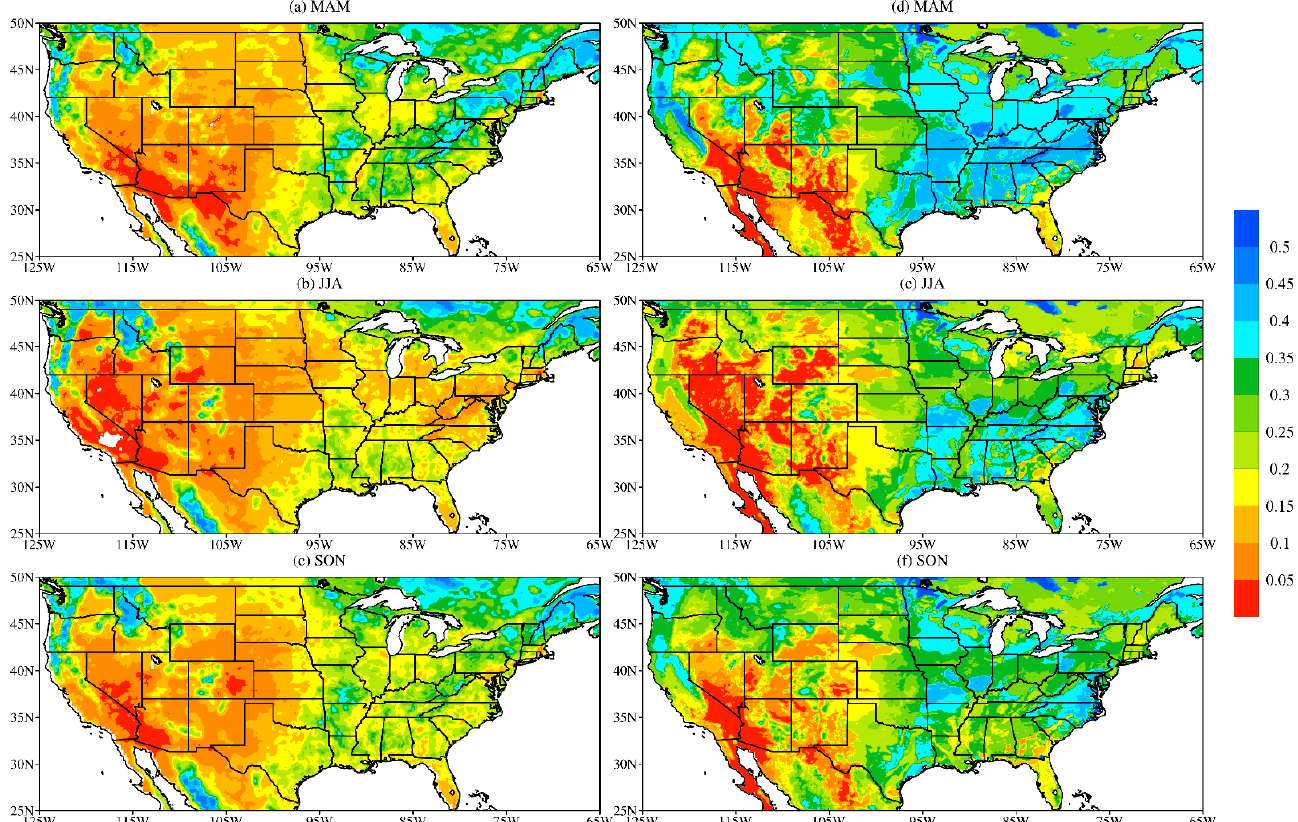
Figure 10. Spatial distribution of the seasonally averaged soil moisture in the United States in spring ( a , d ), summer ( b , e ), and autumn ( c , f ) in 2016. ( a – c ) show the LPRM-based retrieval results, and ( d – f ) show the ERA5-based retrieval results (units: m 3 m − 3 ).